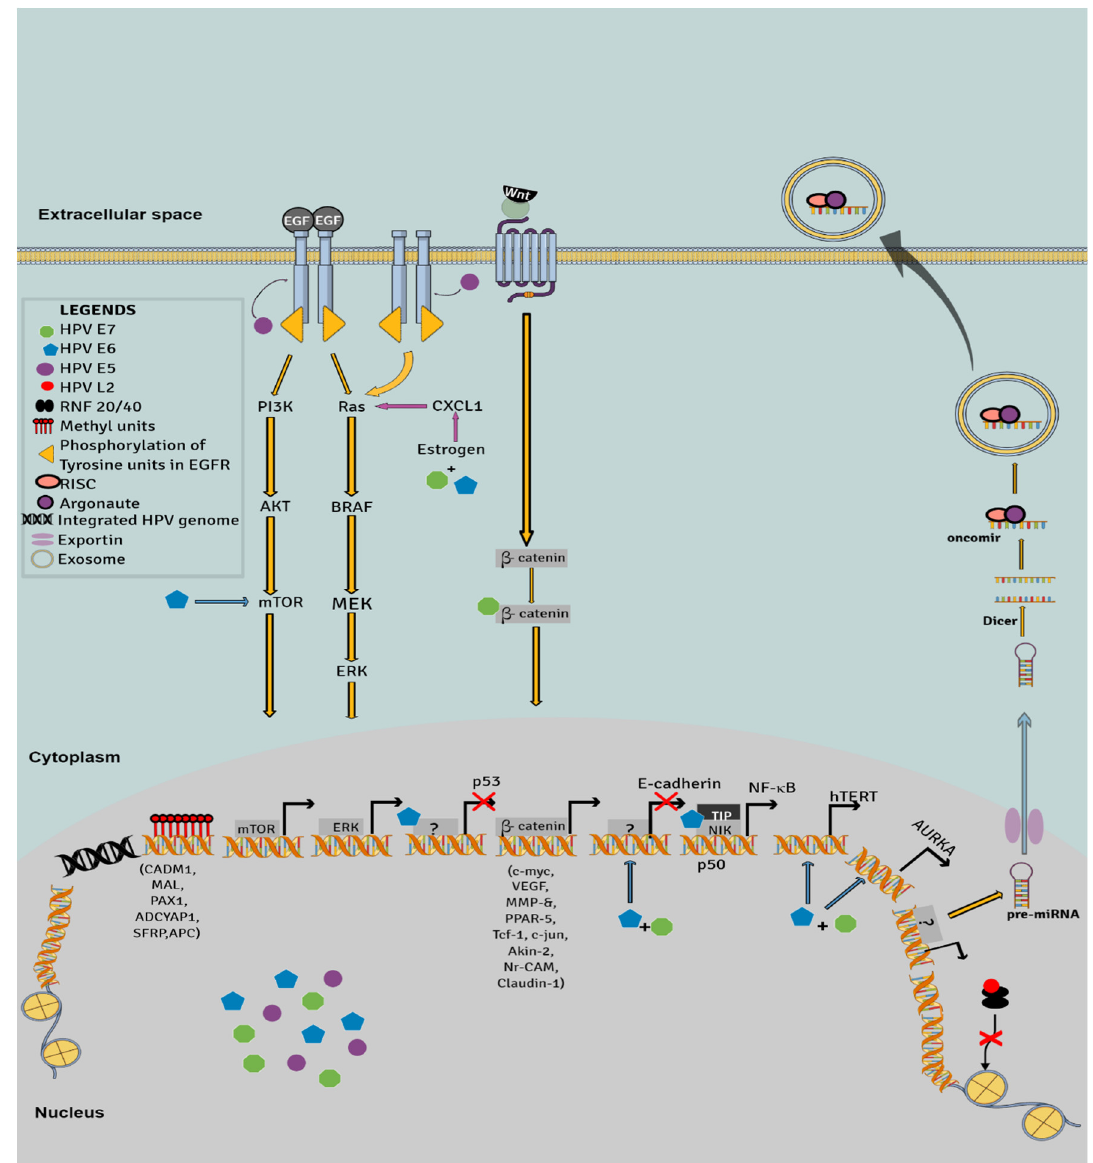
Figure 1. Signaling pathways deregulated in the presence of high-risk HPV. High-risk HPV infection increases cancer risk by: a) Increasing cell proliferation (PI3K/AKT mTOR, Ras-ERK, β-catenin pathways); b) Increasing cell proliferation and progression by the inactivation of p53 expression, E-cadherin and hypermethylation of tumor suppressor genes; c) Increasing immortalization of cancer cells by increasing telomerase activity and AURKA at G2 / M phase; d) Increasing intercellular communication and epithelial-mesenchymal transition by upregulating the expression of oncomirs and inhibiting the interaction of histone proteins with ubiquitin ligases. Abbreviations: phosphoinositide 3-kinases ( PI3K ), serine/threonine-protein kinase ( AKT ), mammalian target of rapamycin ( mTOR ), epidermal growth factor ( EGF ), GTPase Ras ( Ras ), serine/threonine-protein kinase B-raf ( BRAF ), mitogen-activated protein kinases ( MEK and ERK ), chemokine (C-X-C motif) ligand 1 ( CXCL1 ), telomerase reverse transcriptase ( hTERT ), aurora kinase A ( AURKA ), cell adhesion molecule 1 ( CADM1 ), myelin and lymphocyte protein ( MAL ), paired box 1 ( PAX1 ), adenylate cyclase activating polypeptide 1 ( ADCYAP1 ), secreted frizzled-related protein ( SFRP ) and adenomatous polyposis coli ( APC ), NF- κ B-inducing kinase ( NIK ), and TRAF-interacting protein ( TIP